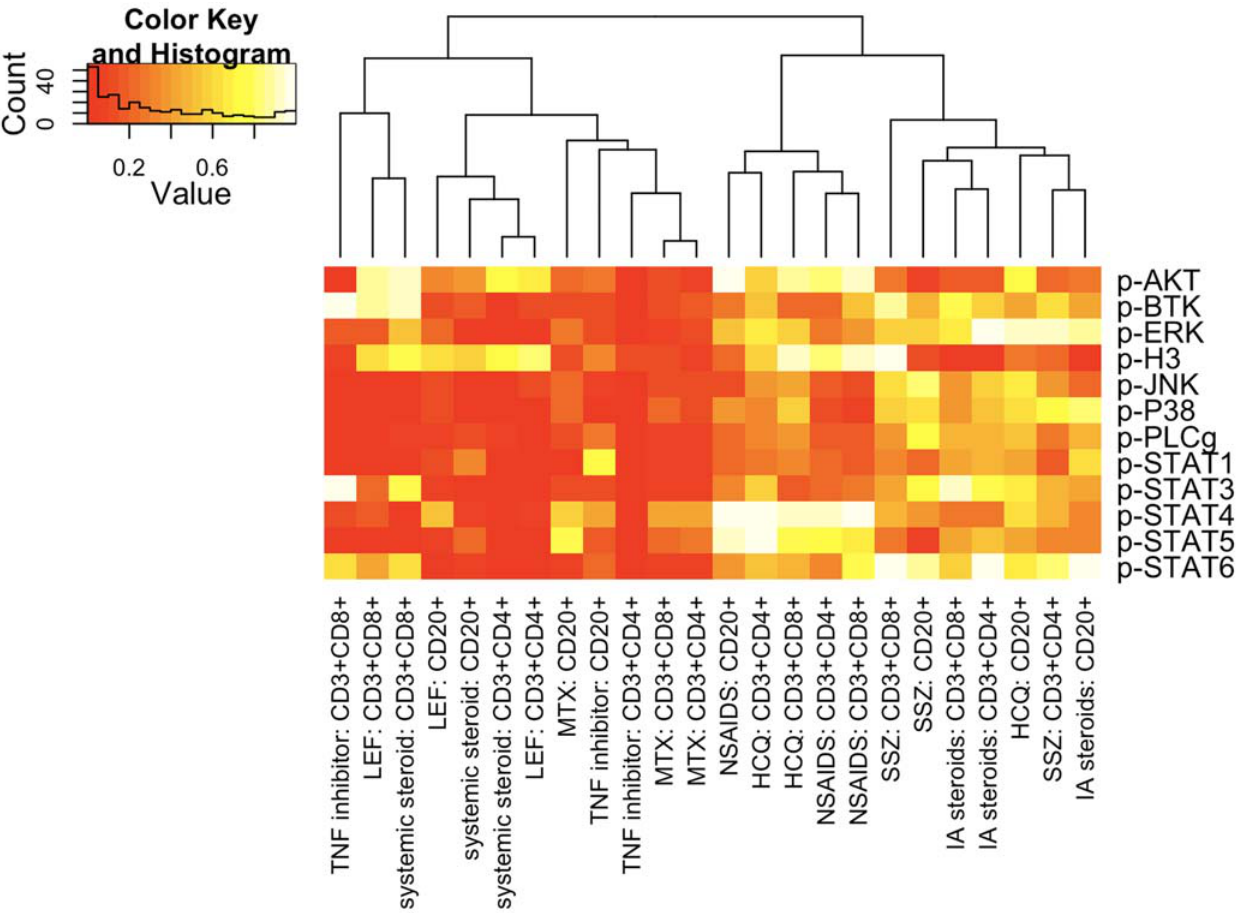
Figure 6. Drug therapy affects the phosphorylation levels of signaling effectors in ERA PBMC. Hierarchical clustering heatmap showing the level of statistical significance, as a p value, for the difference in MFI values for each indicated phospho-signaling effector comparing patients on therapy versus patients not on therapy. Statistical differences were calculated by Student’s t test.